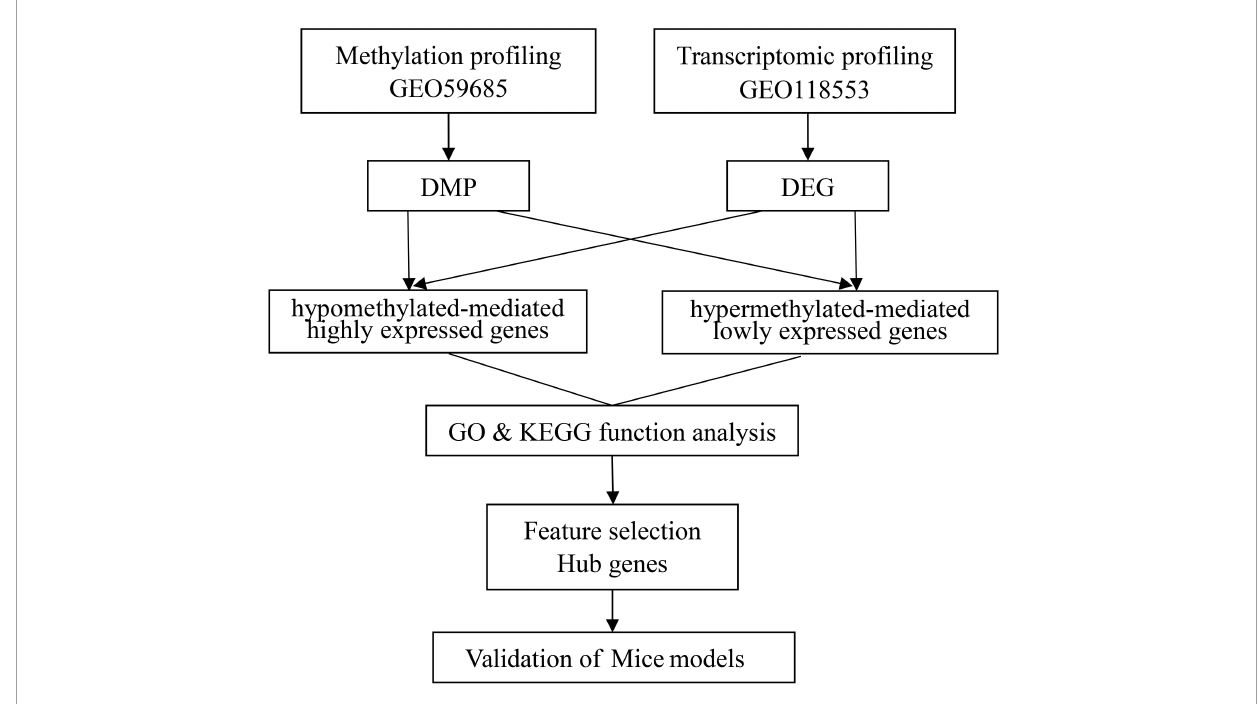
FIGURE1 A flowchart of the study